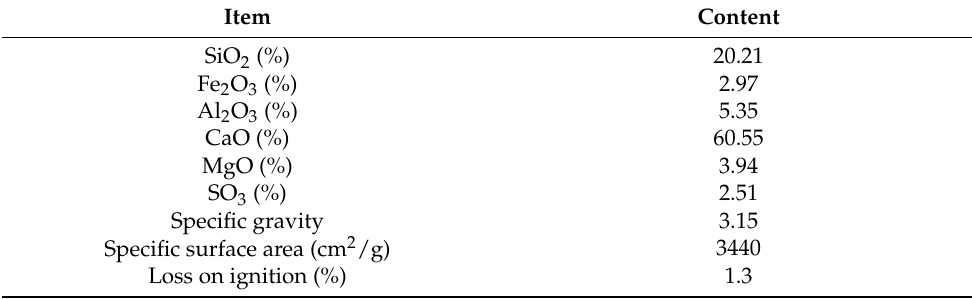
Table 1. Chemical composition and physical properties of the cement used.